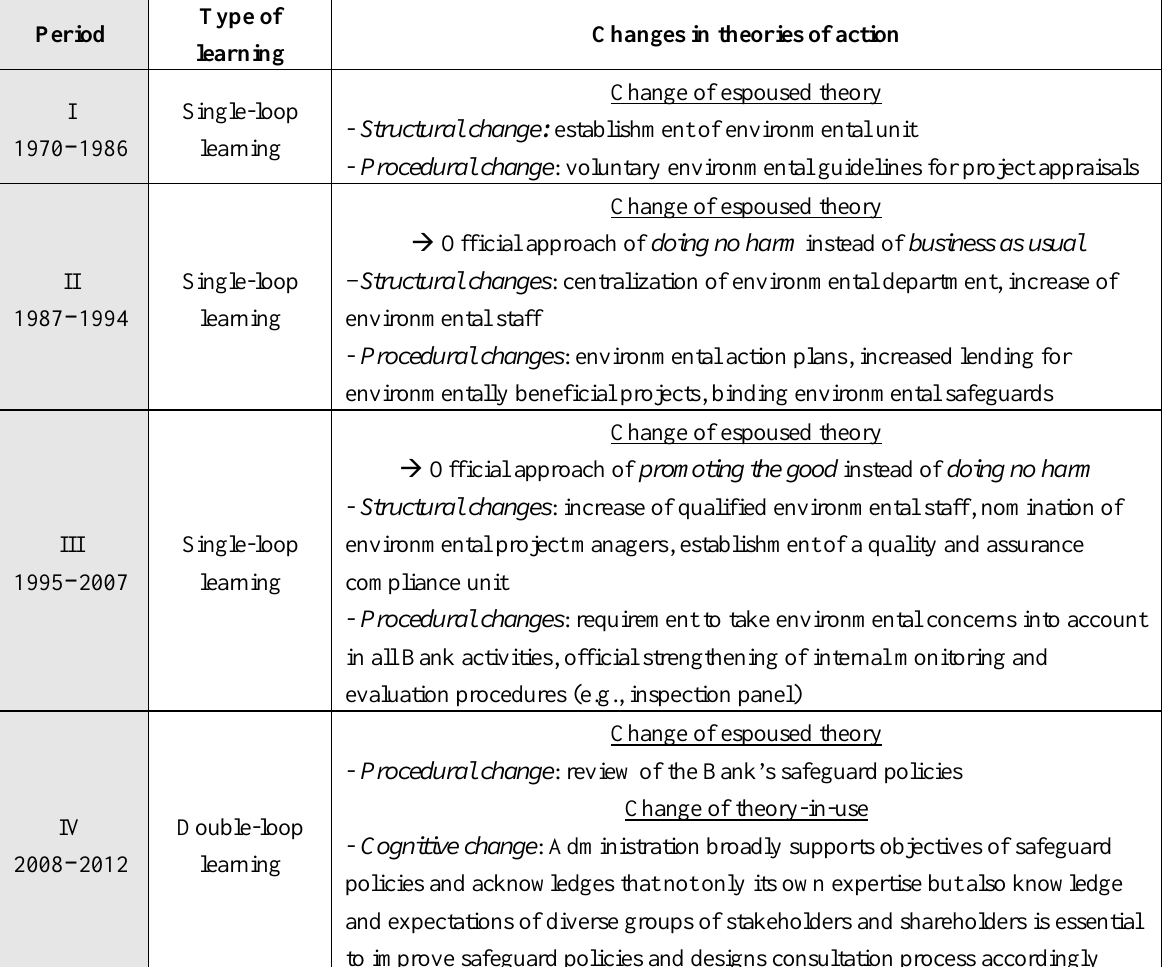
Table 2. Organizational Learning within the World